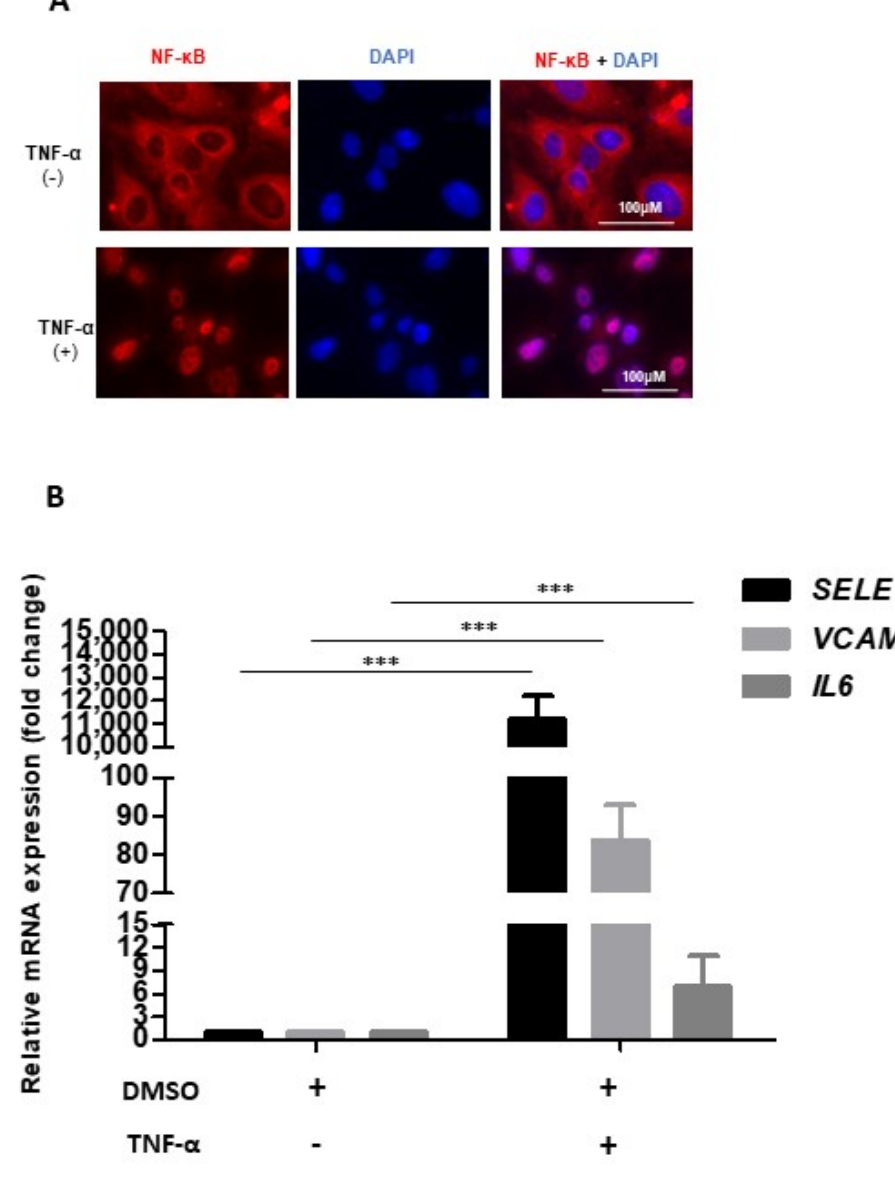
Figure 1. Establishment of inflammatory phenotype in HUVECs. ( A ) Immunofluorescence images showing control ( − ) and TNF- α treated (+) HUVECs which were stained with anti-NF- κ B antibody (red) and nuclei were counter-stained with DAPI (blue). ( B ) Bar graph showing relative mRNA levels of SELE, VCAM-I, and IL6 after normalization to housekeeping gene GAPDH, in DMSO control and TNF- α treated cells. One-way ANOVA with Tukey’s post-test was used; values are mean ± SD of three biological replicates (*** = p < 0.0001).